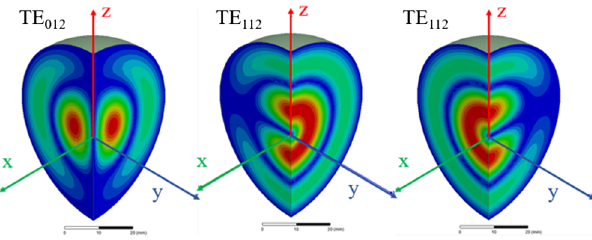
FIG. 9. Field patterns from different views of spherical resonant cavities with TE 012 and two TE 112